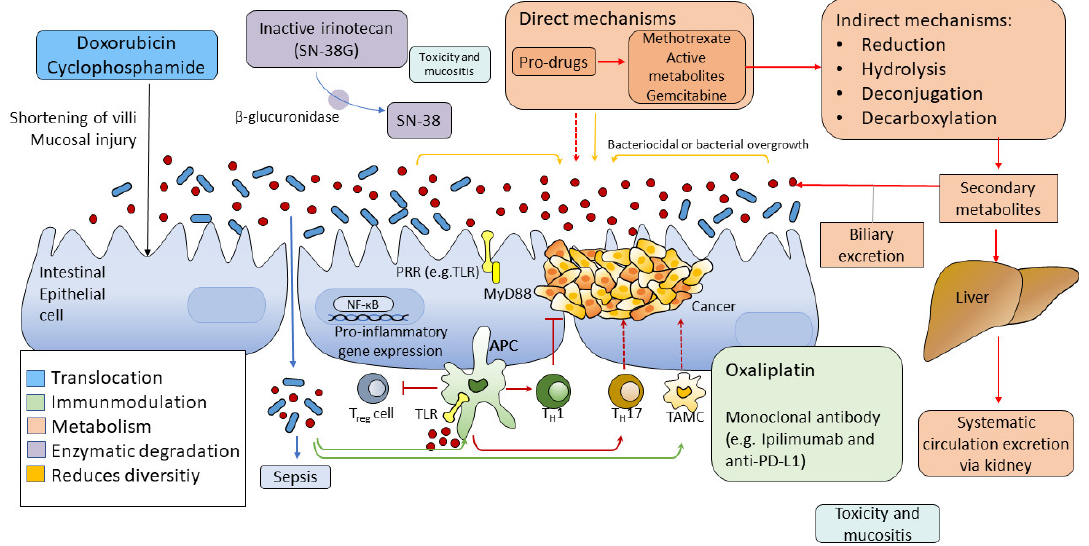
Figure 2. The microbiome can change the efficacy and toxicity of chemotherapeutic agents. TIMER is an acronym for the effects of chemotherapy on the gut microbiome. ‘T’ stands for translocation: bacteria migrate through the gut wall into the lymphatic system or the systemic circulation. ‘I’ stands for immunomodulation: gut microbiome might enhance chemotherapy-induced immune responses. ‘M’ stands for metabolism: the microbiome has direct and indirect effects on the effects of chemotherapy; it might strengthen or reduce the desired effects or promotes the release of toxic compounds. ‘E’ stands for: enzymatic degradation: gut microbiome has a wide range of enzymes capable of creating metabolites that can cause undesired side effects. ‘R’ stands for reduced diver- sity: chemotherapy can be a cause of dysbiosis. (Figure was based on the work of Alexander, J. L. et al. [28].